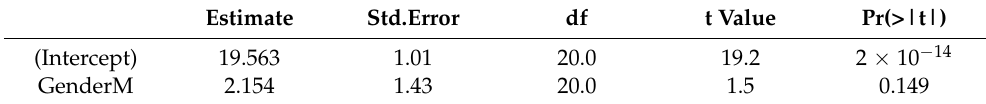
Table 3. Fixed effects of gender on F0.